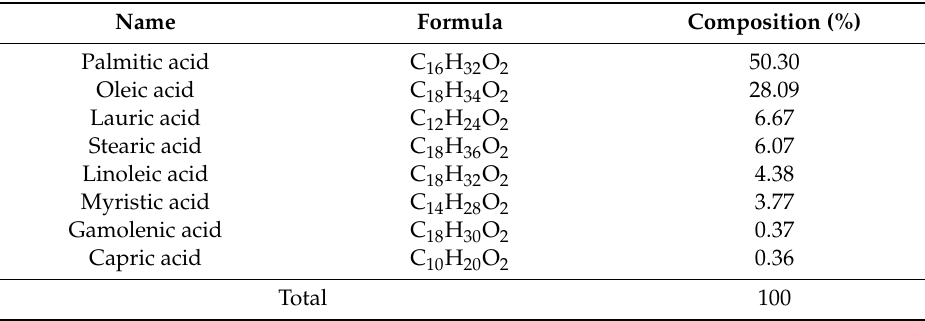
Table 1. Free fatty acids composition in PFAD.